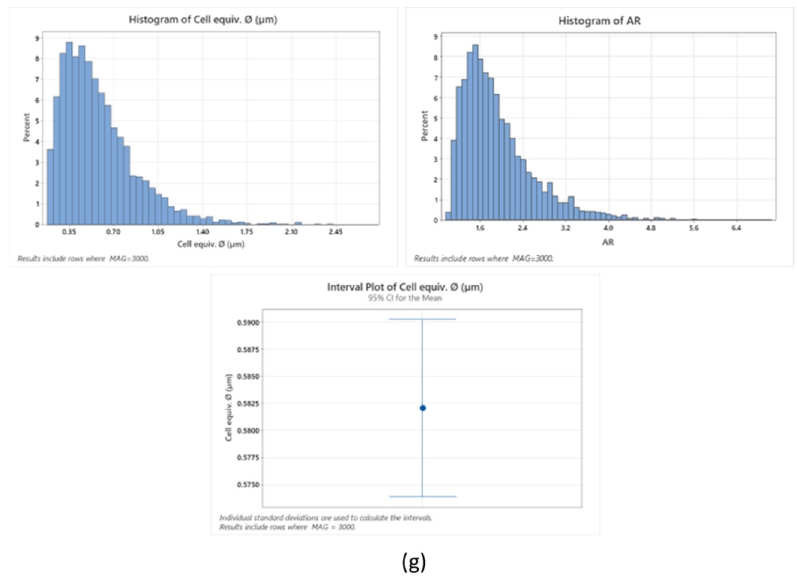
Figure 7. Cryo-scanning electron microscopy of Tuna gelatin hydrogel at different magnifications: ( a ) X1000, ( b ) X2000, ( c ) X5000, ( d – f ) X3000 . ( g ) Statistical analysis of cell size-distributions and cell aspect-ratio distributions obtained from the three micrographs captured at X3000 magnification (average of three results).